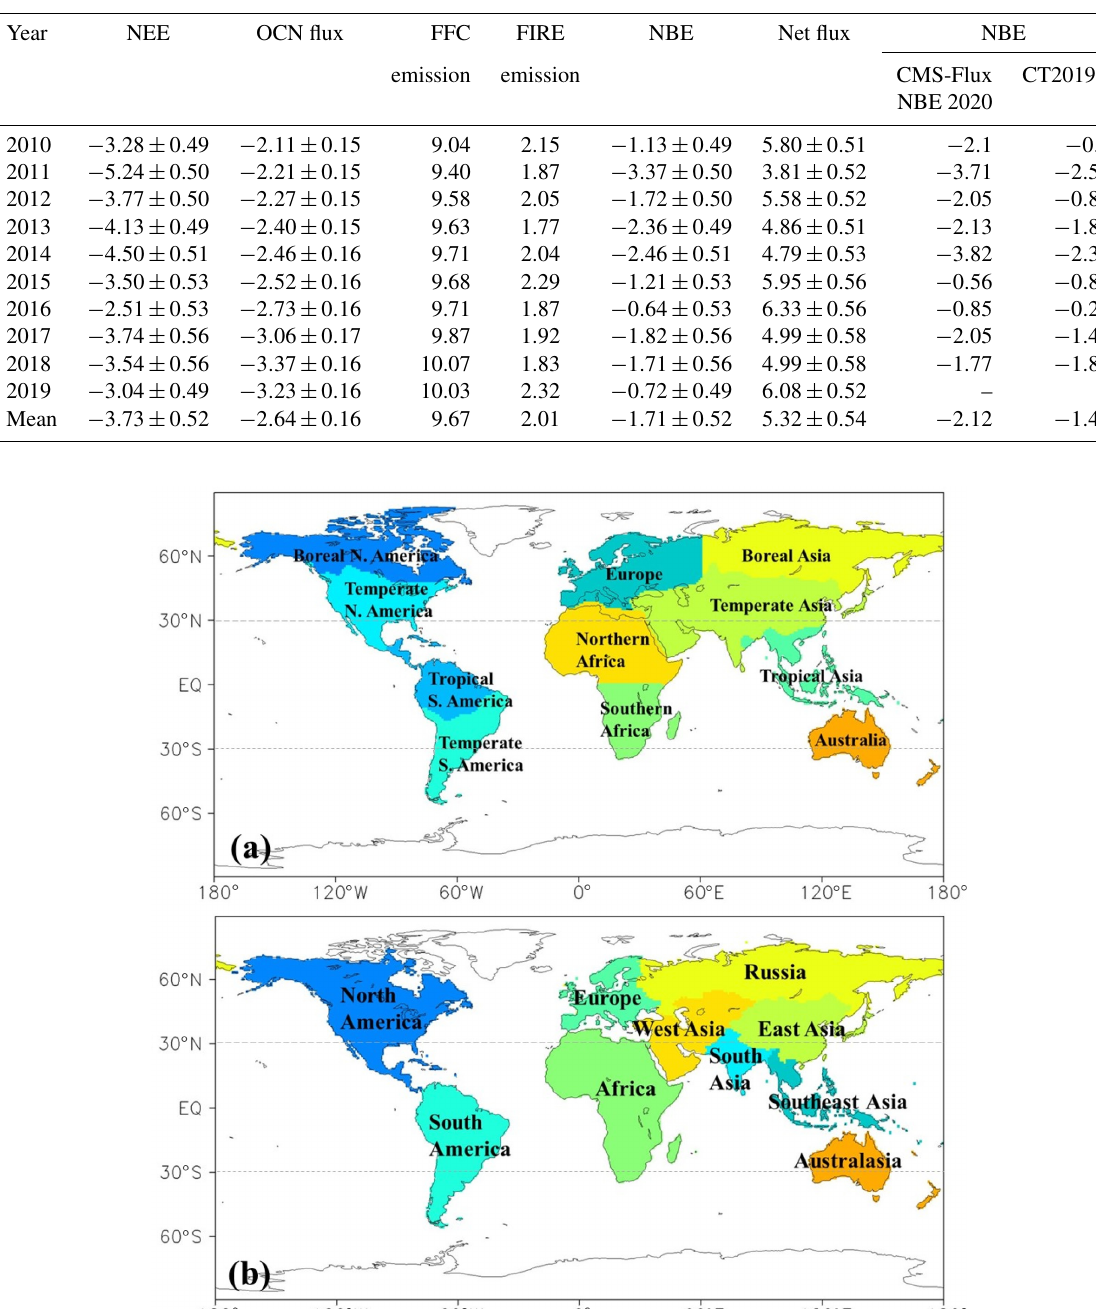
changes of GOSAT XCO 2 in 2015 and 2019 and compare them with the OCO-2 XCO 2 retrievals (OCO-2 v10, OCO- 2 Science Team, 2020). We find that after detrending, in TL, the GOSAT XCO 2 in 2019 is higher than that in 2015, while OCO-2 is the opposite (Fig. S3). For the prior